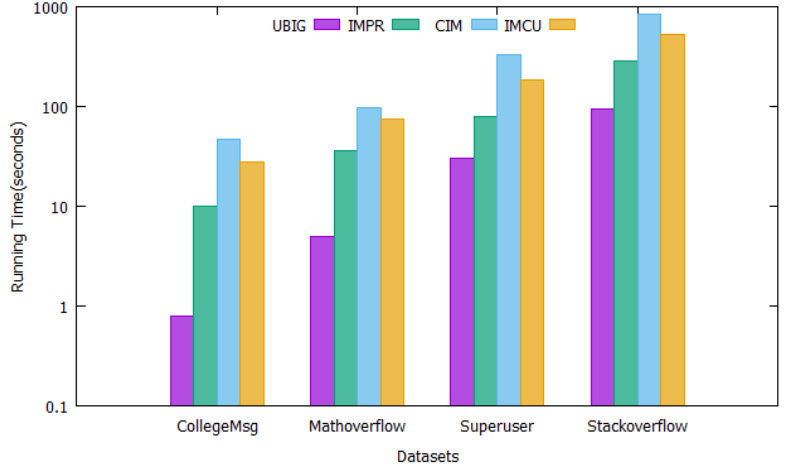
Figure 6. Comparison of IMPR and three other algorithms in running time.